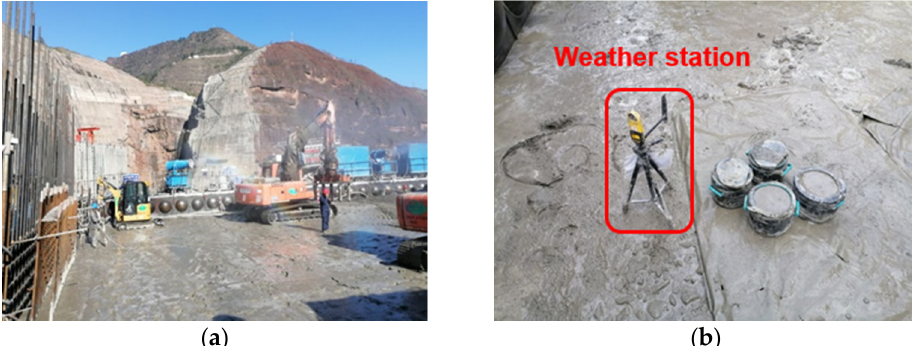
Figure 2. Construction site: ( a ) storehouse surface and spray equipment. ( b ) penetration resistance test and a small weather station.